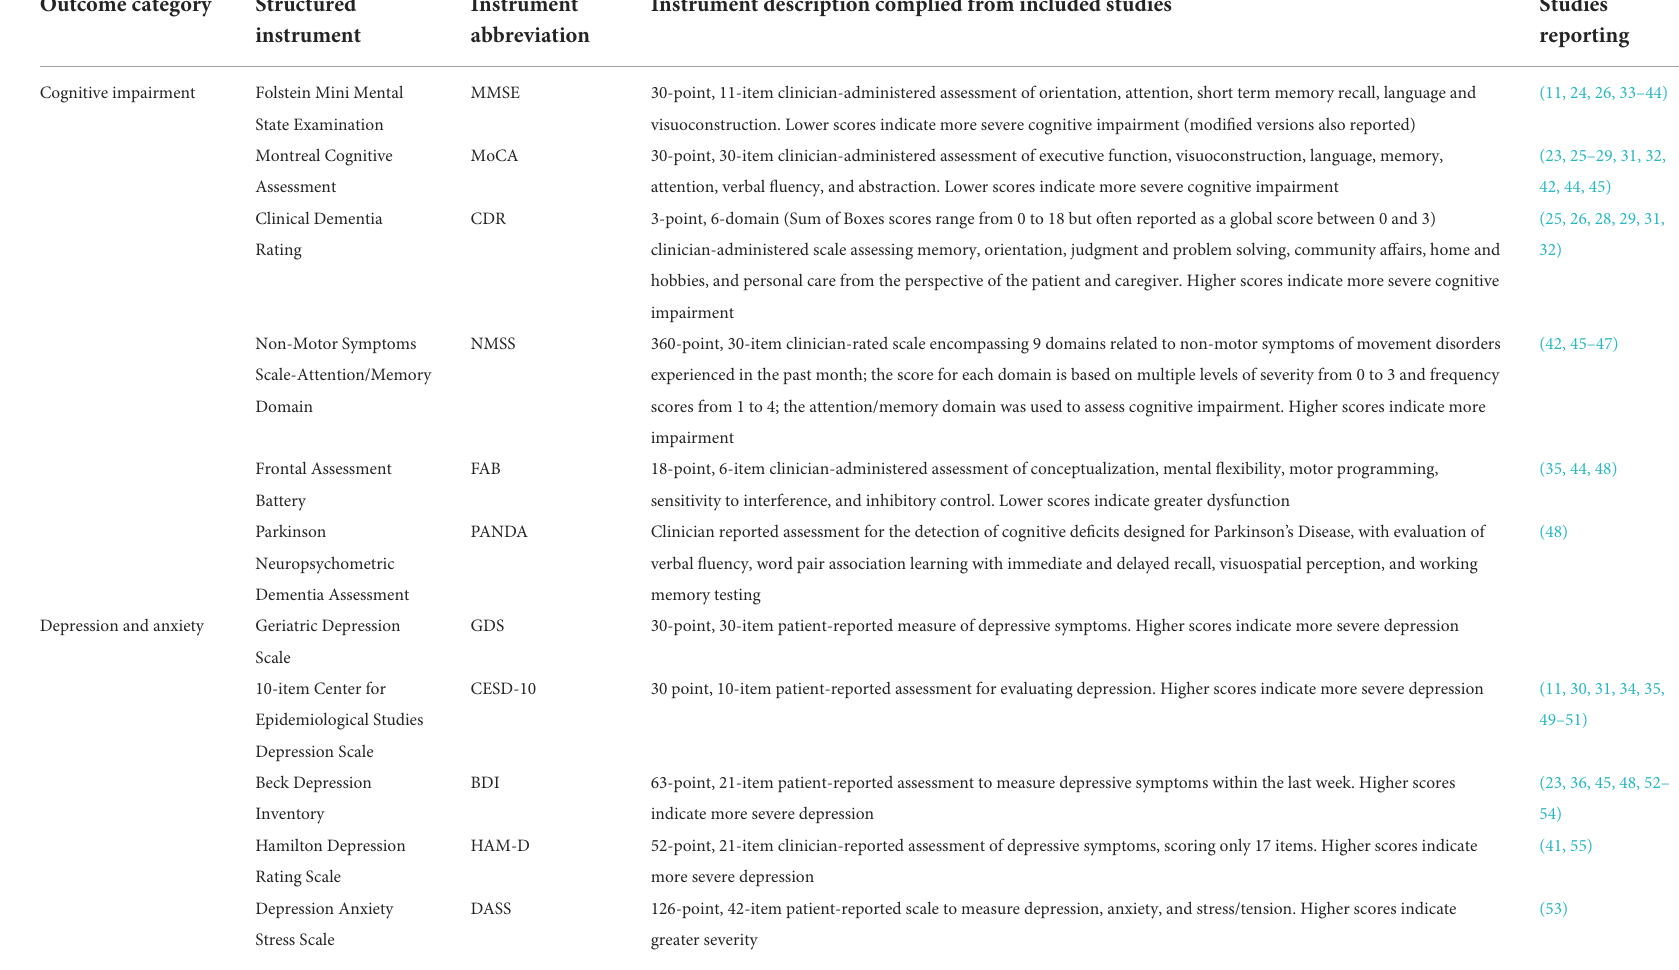
TABLE 1 Description of structured instruments reported in included